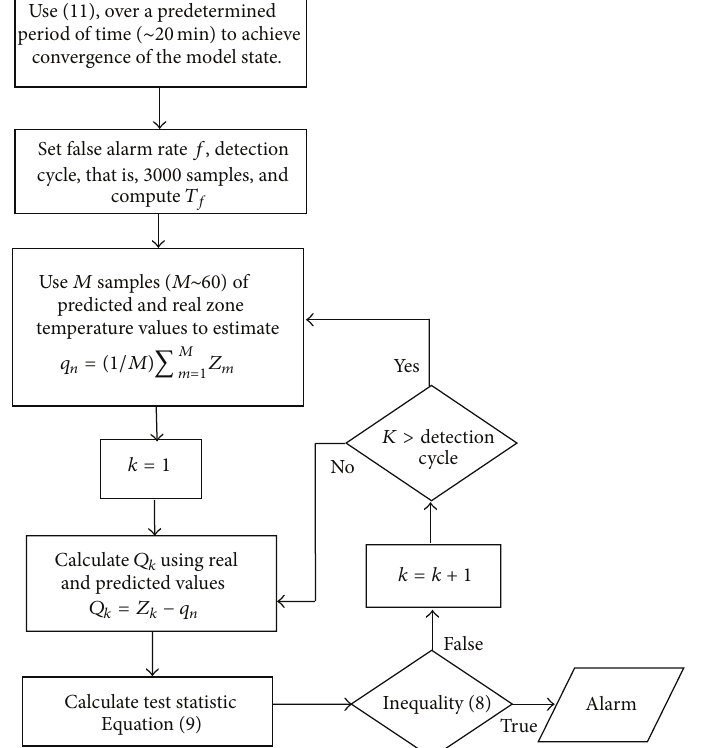
Figure 3: Detection phase steps of the algorithm.